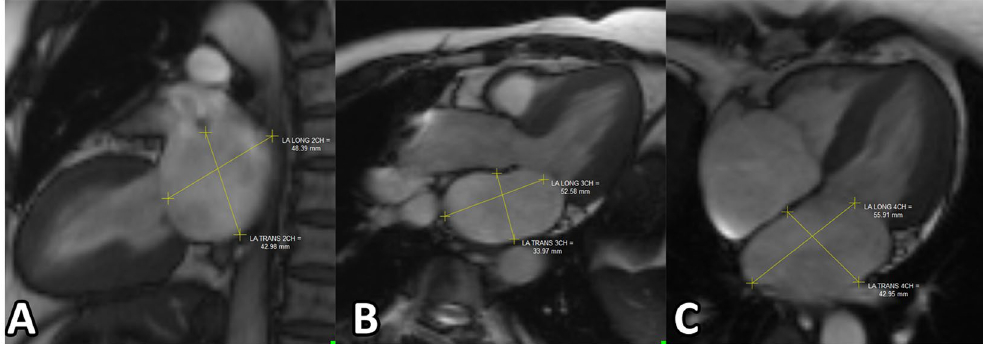
Figure 1. Measuring the left atrium dimension in a 2-chamber view, 3-chamber view, and 4-chamber view. ( A ) longitudinal dimension and transverse dimension in the 2-chamber view. ( B ) longitudinal dimension and antero-posterior dimension in the 3-chamber view. ( C ), longitudinal dimension and transverse dimension in the 4-chamber view. Yellow lines indicate the dimensions